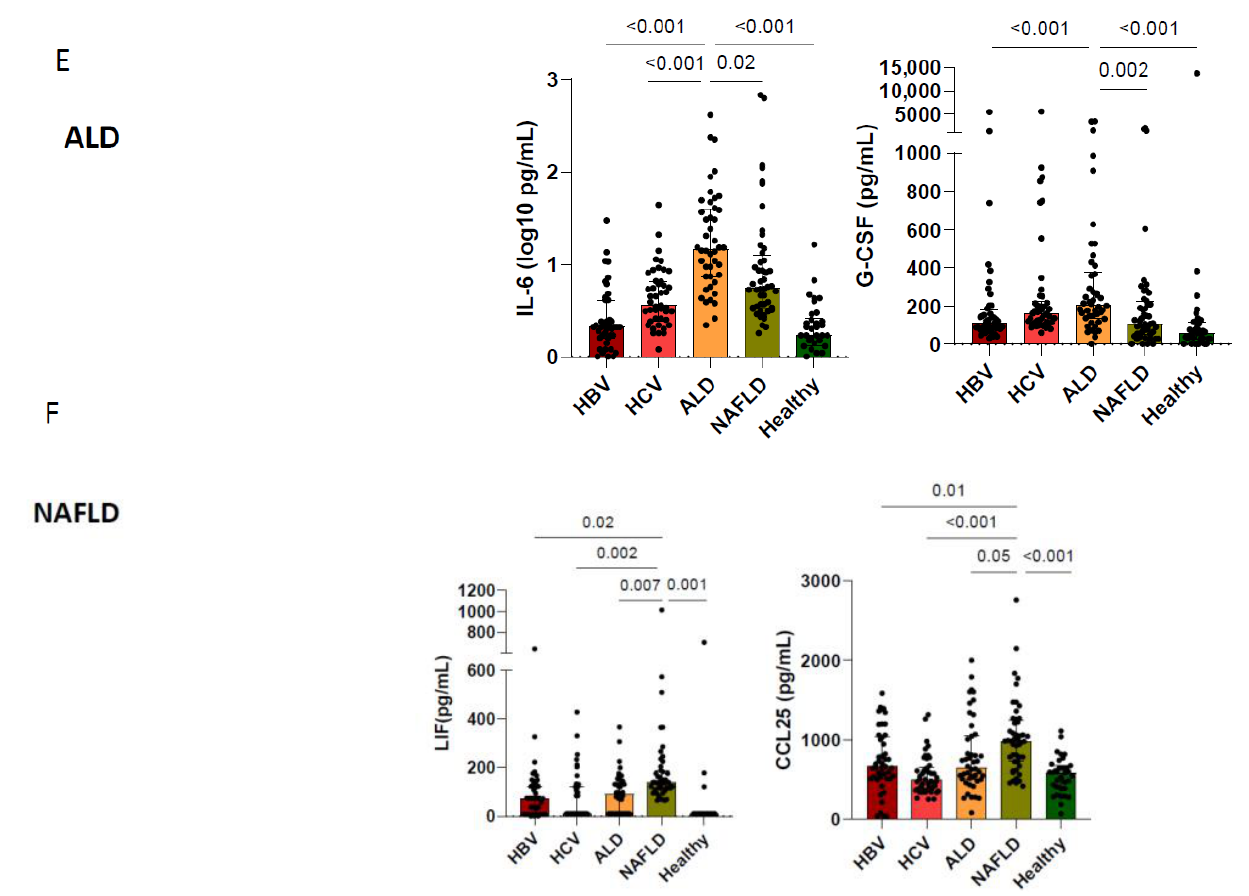
Figure 2. Heatmap of median protein levels with hierarchical clustering of the 53 significant circulating analytes in healthy controls and HBV, HCV, ALD and NAFLD cirrhosis patients ( A ). Scatter dot plots with a selection of significantly different circulating cytokines levels in cirrhosis per etiology: HBV ( B ) HCV ( C ), ALD ( D , E ) and NAFLD ( D , F ). All presented p values are adjusted for multiple comparisons using the Bonferroni method.